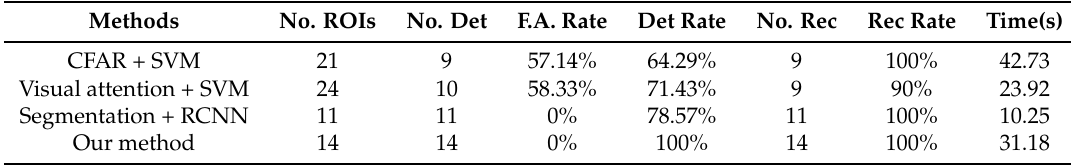
Table 5. Results on large scene SAR image with complex background.